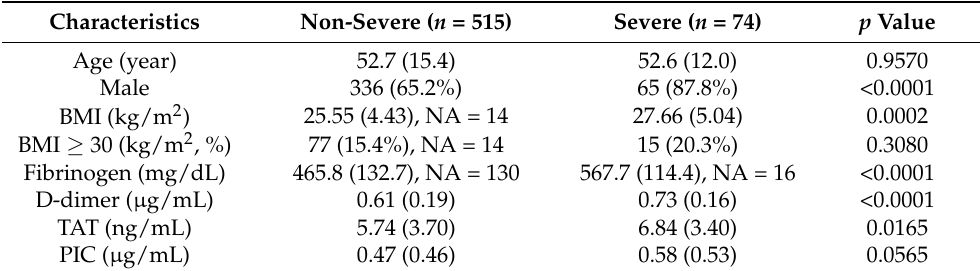
Table 3. Characteristics of patients in the normal D-dimer group.